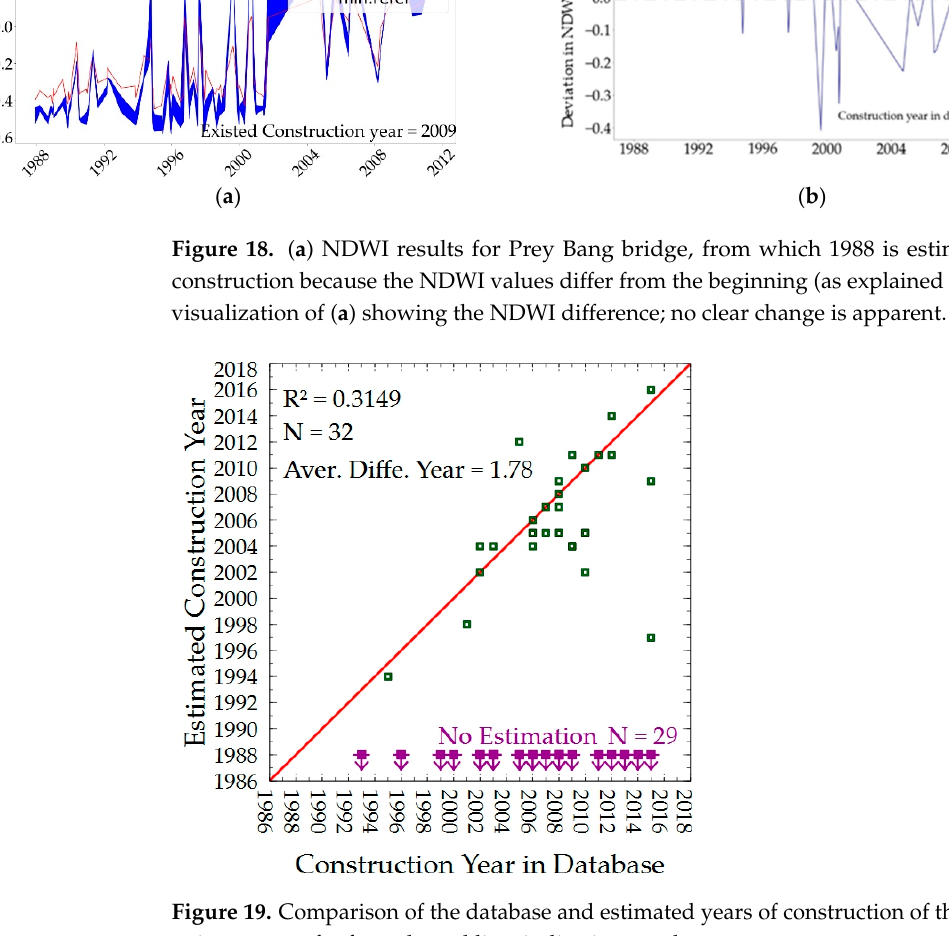
points are not far from the red line, indicating good accuracy.